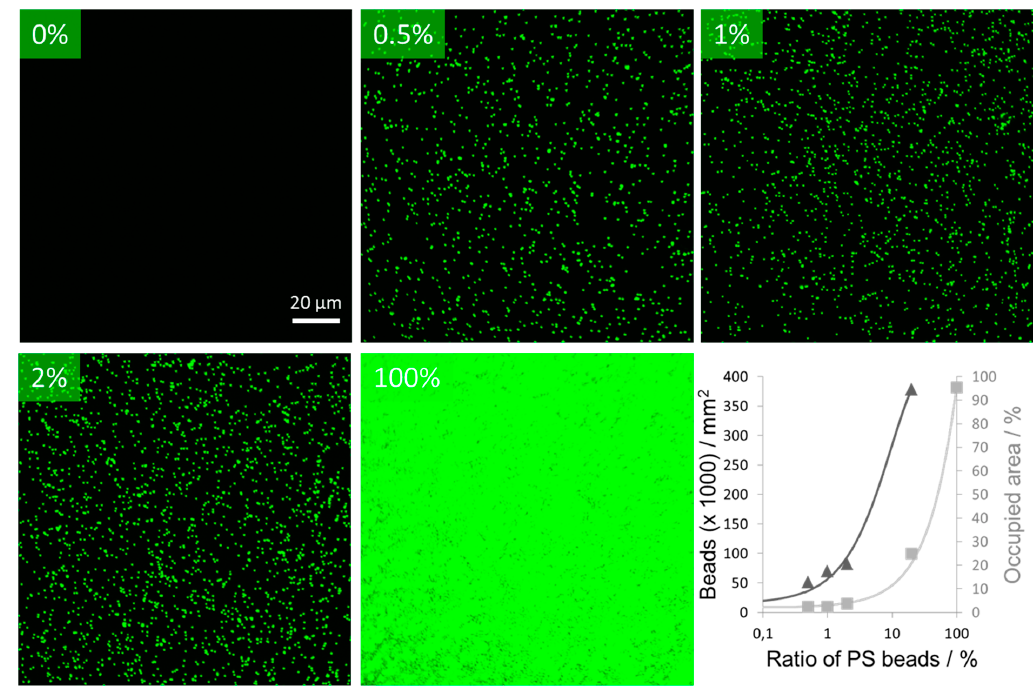
Figure 5. The surface density of polystyrene (PS) beads coadsorped with microgels can predictably and homogenously be adjusted through the bead ratio of the coating suspension. Fluorescence microscopy images of poly(ethylenimine) (PEI) glass slides taken after coadsorption of microgels and fluorescent PS beads using various mixing ratios of the suspensions (0%, 0.5%, 1%, 2%, and 100% beads). With increasing numbers of PS beads in the solution, the number of beads on the surface also increased. The number of beads per area was counted (triangles, left ordinate). The area occupied by the fluorescent beads was measured (squares, right ordinate). Both measures are approximately linearly related to the ratio of beads in the coating suspension (note logarithmic abscissa). Solid lines added only as guide to the eye.